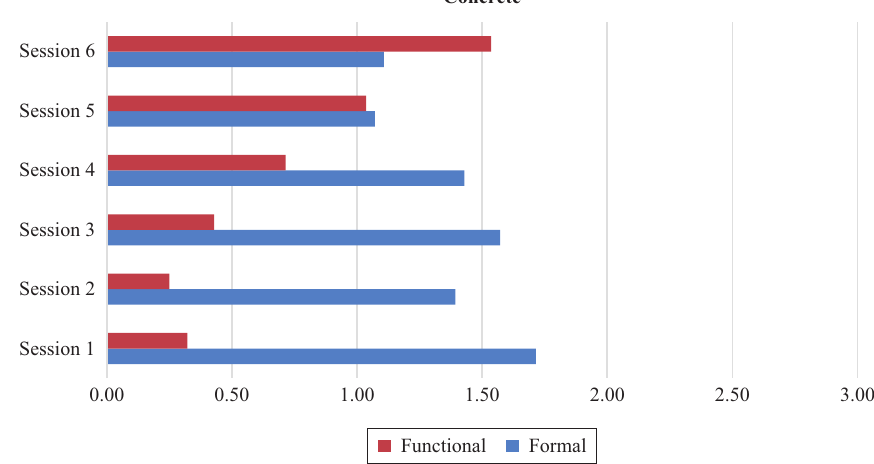
Fig. 4. Transformations occur according to concrete-oriented concepts created during design sessions